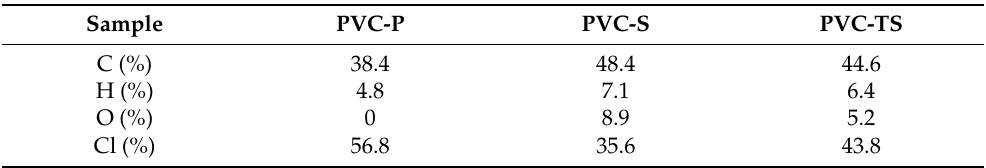
Table 2. Elementary analysis of various PVC samples.